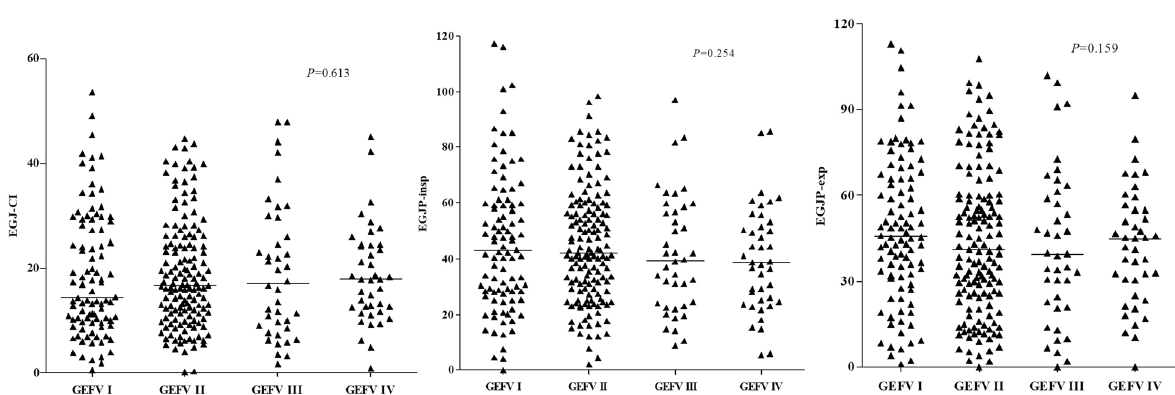
Figure 3. Associations of GEFV grade with EGJ-CI, EGJP-insp, and EGJP-exp. GEFV gastroesophageal flap valve, EGJ esophagogastric junction, EGJ-CI EGJ-contractile, EGJP-insp inspiratory EGJ pressure, EGJP-exp expiratory EGJ